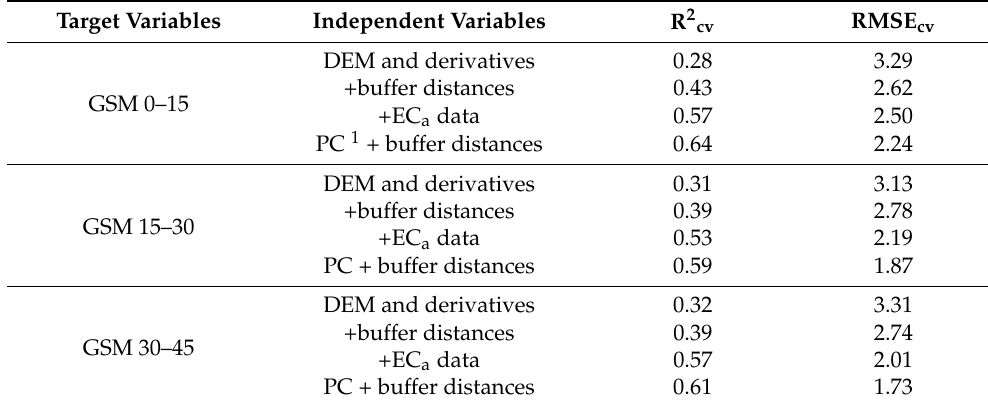
Table 3. Spatial cross validation results of manual stepwise including the independent